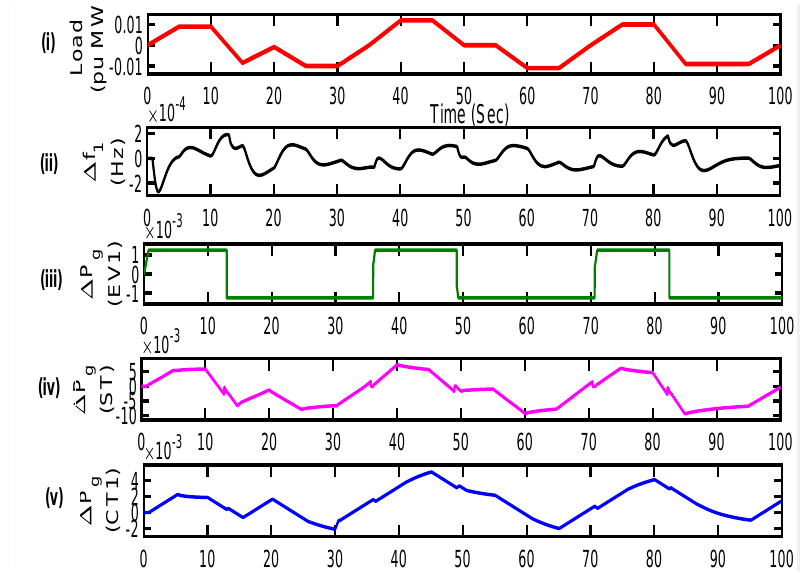
Figure 16. Generation power of multi-energy sources in Area